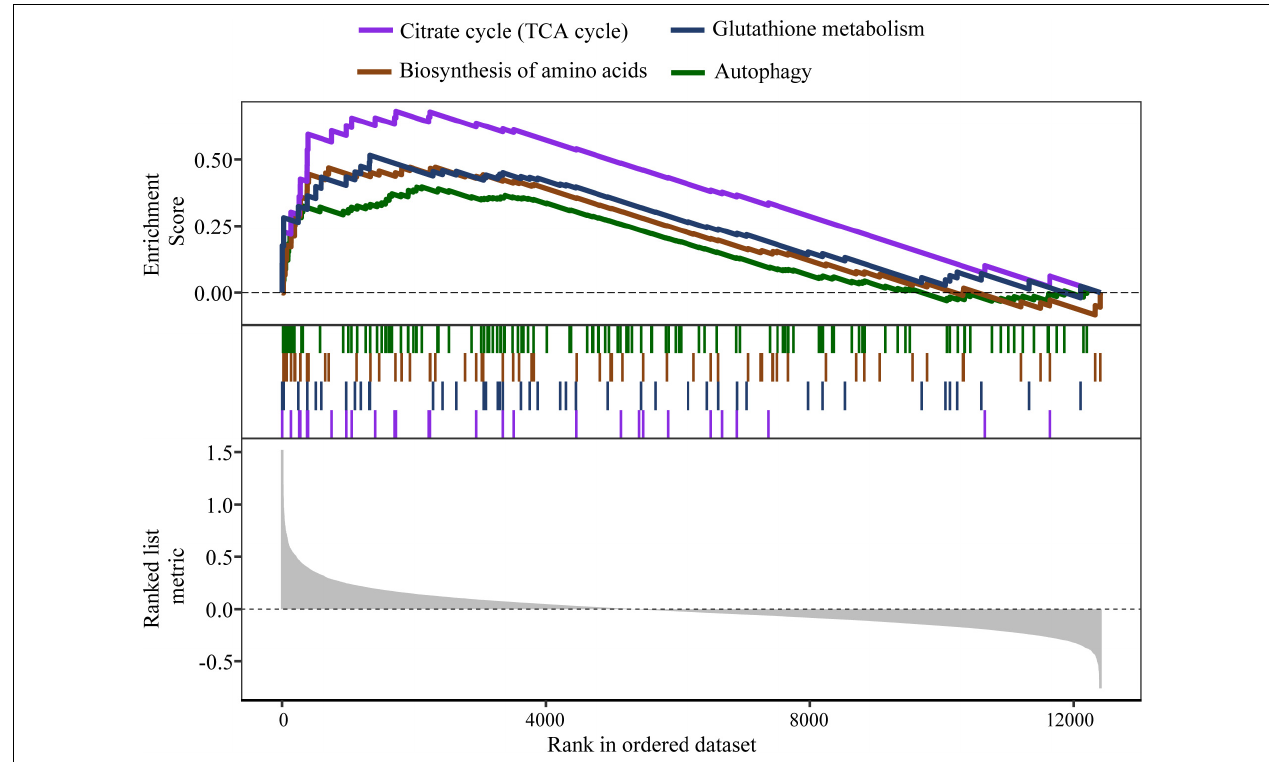
FIGURE 5 | Representative GSEA enrichment pathways of GHK-induced transcriptional responses. The pathways shown in the picture are citrate cycle (TCA cycle) (hsa00020); glutathione metabolism (hsa00480); biosynthesis of amino acids (hsa01230); and autophagy-animal (hsa04140).